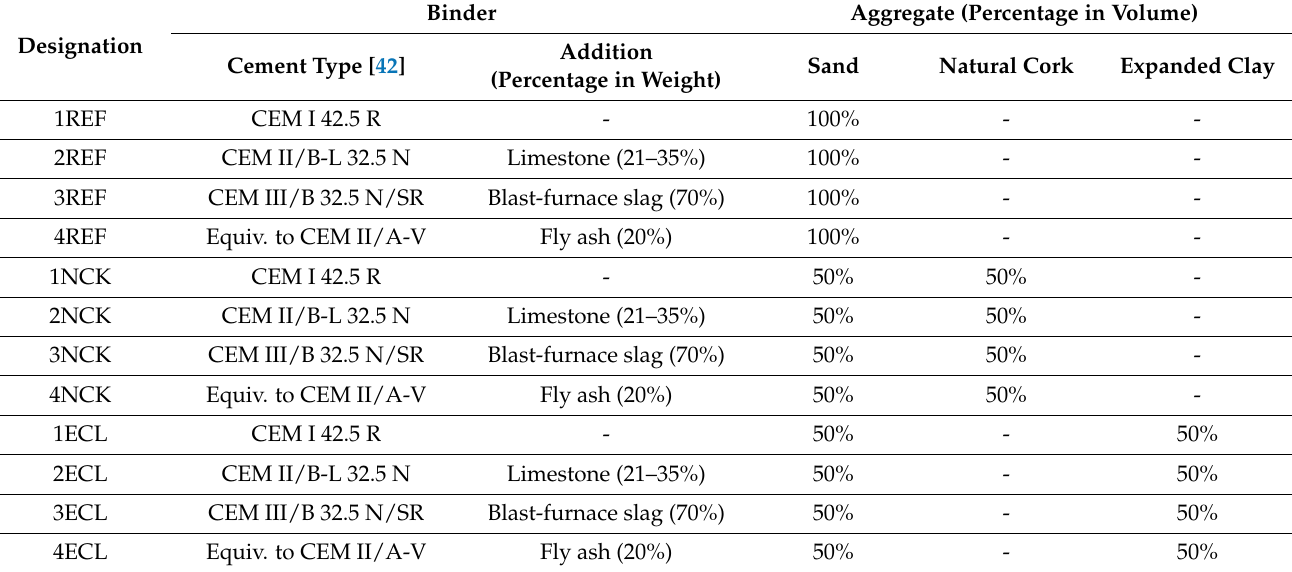
Table 1. Components (binder and aggregates) and designation of the mortar series tested.